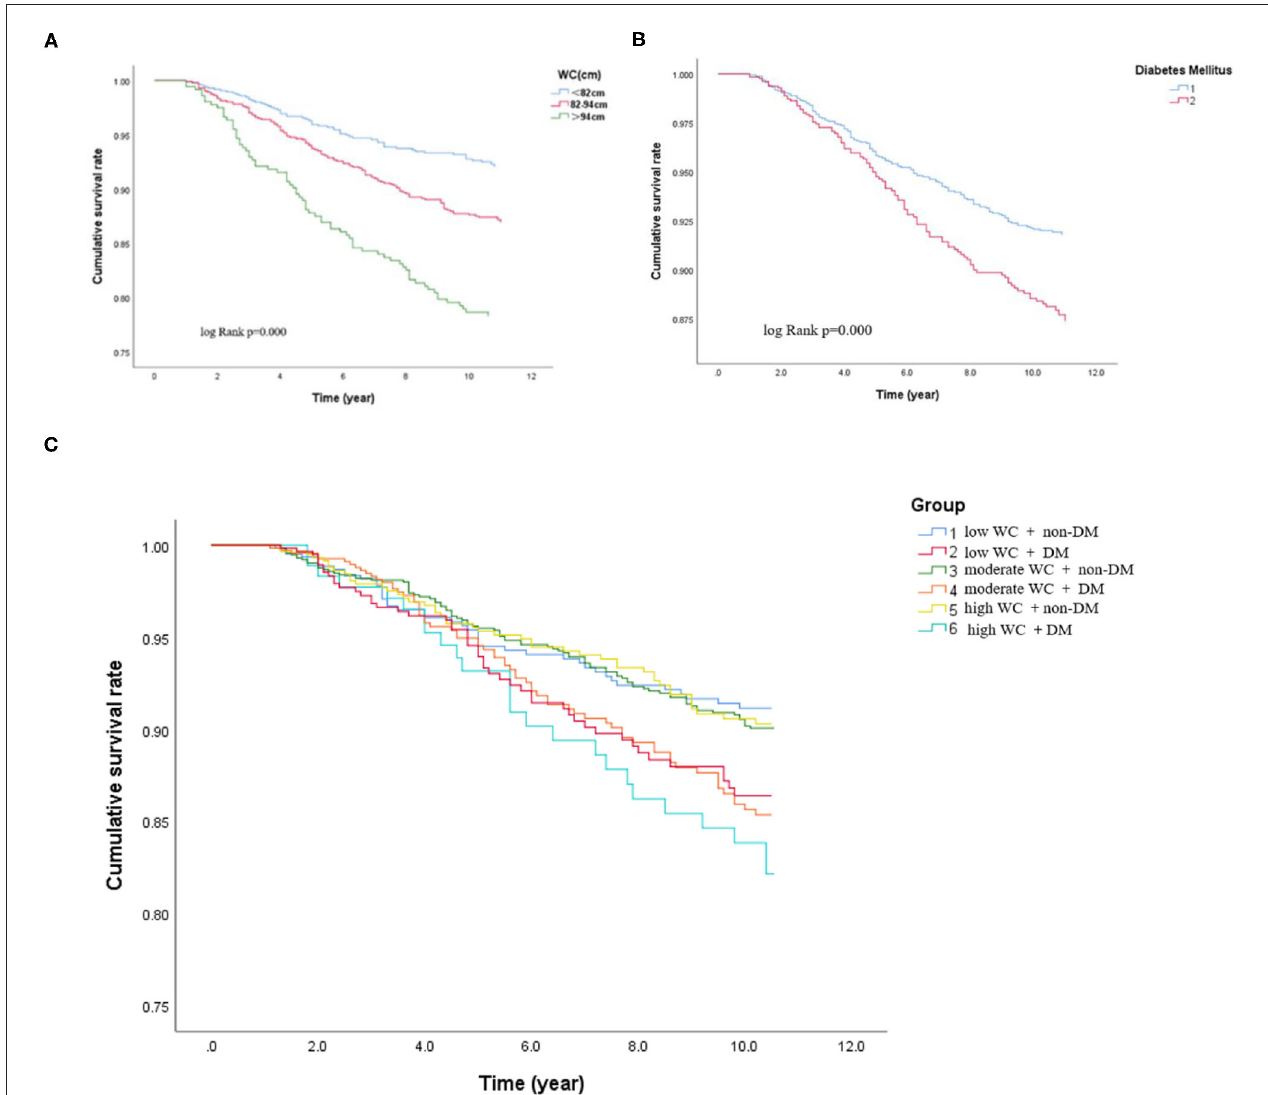
FIGURE 3 | Cox-adjusted event-free survival curves for freedom of cardiovascular death in the different subgroups after adjustment for potential clinical confounders. (A) Cox-adjusted event-free survival curves of the participants according to the different WC levels. (B) Cox-adjusted event-free survival curves of the participants with or without DM. (C) Cox-adjusted event-free survival curves of the participants with DM and non-DM according to different degree of